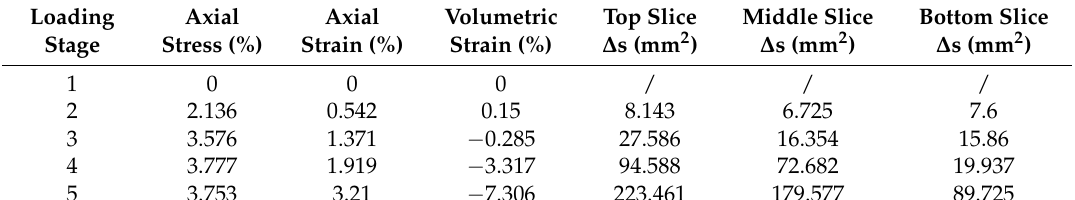
Table 4. Stress–dilatancy characterization of the CWRTB sample under triaxial compression.